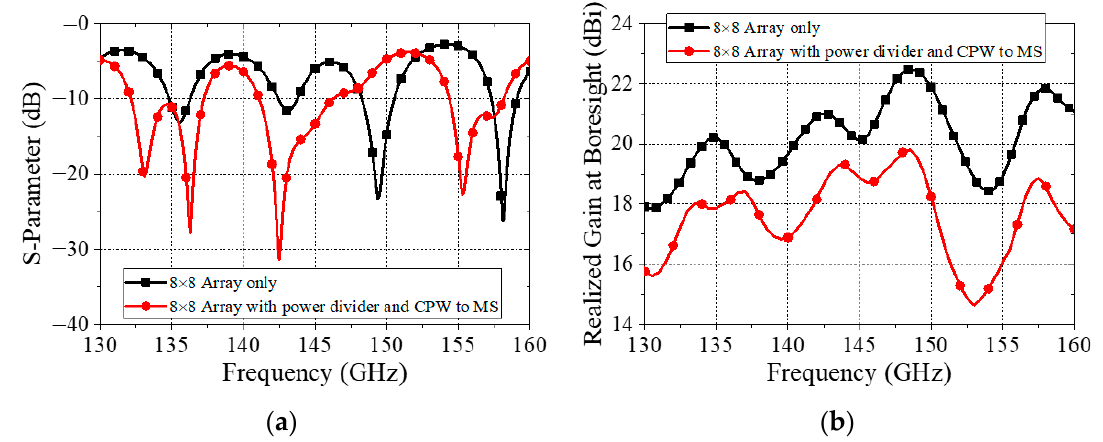
Figure 14. ( a ) S-parameter and ( b ) realized gain at boresight of eight-by-eight array with or without power divider and CPW to MS transition.